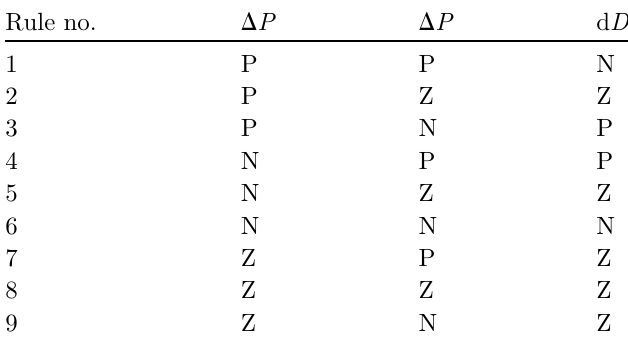
Table 2. Inference